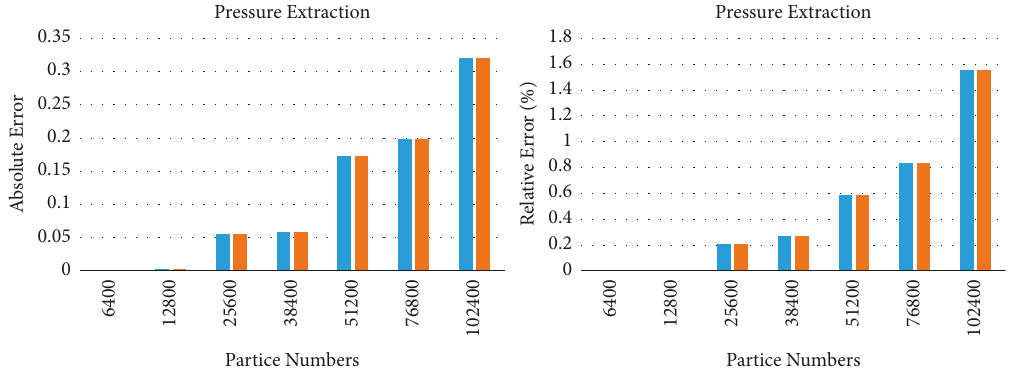
Figure 9: Error analysis of the GPU algorithm for pressure extraction relative to the CPU algorithm.